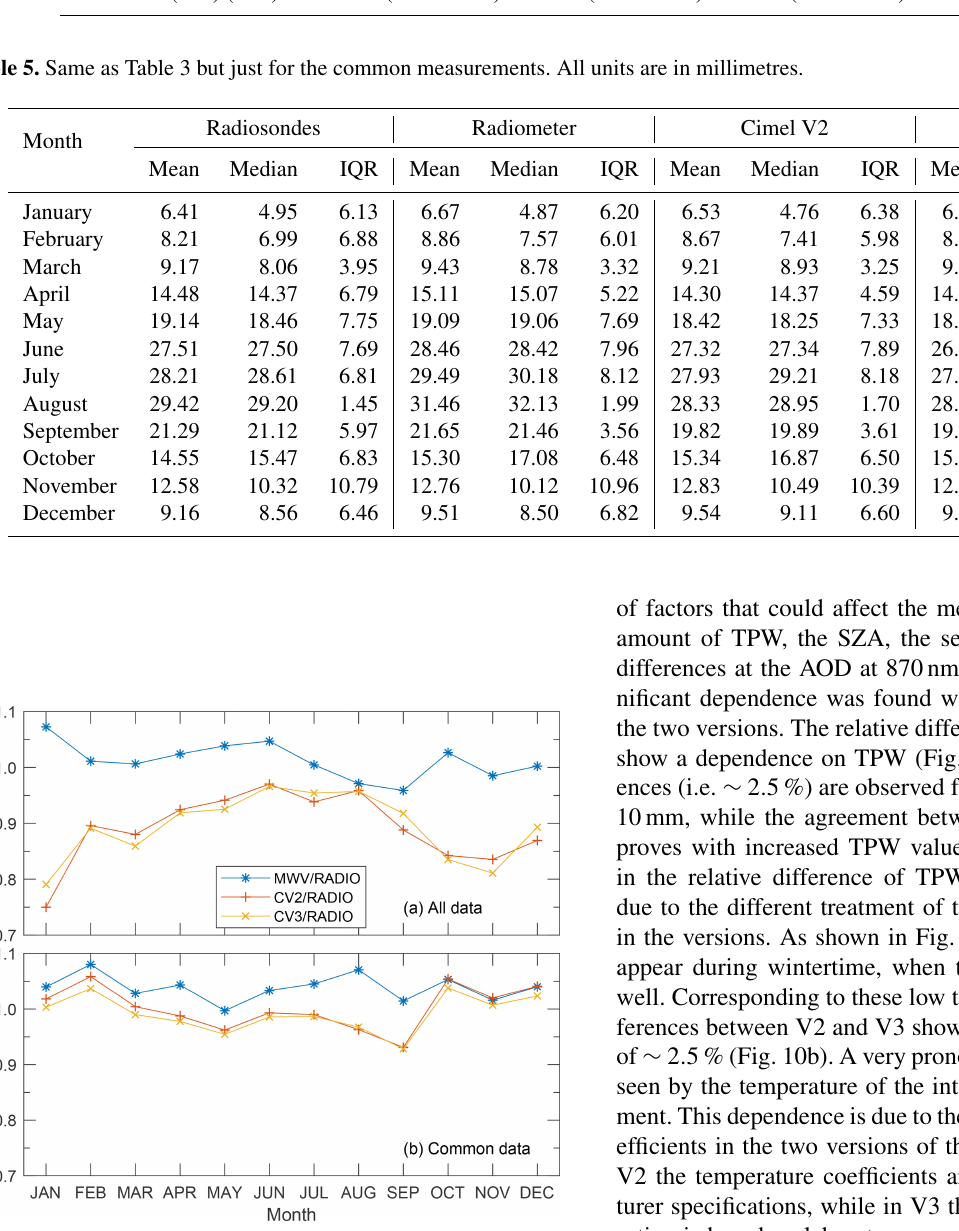
Figure 4. Monthly ratio of TPW among microwave radiometer, Cimel V2 and V3, and radiosondes (a) for all the available mea- surements and (b) for their